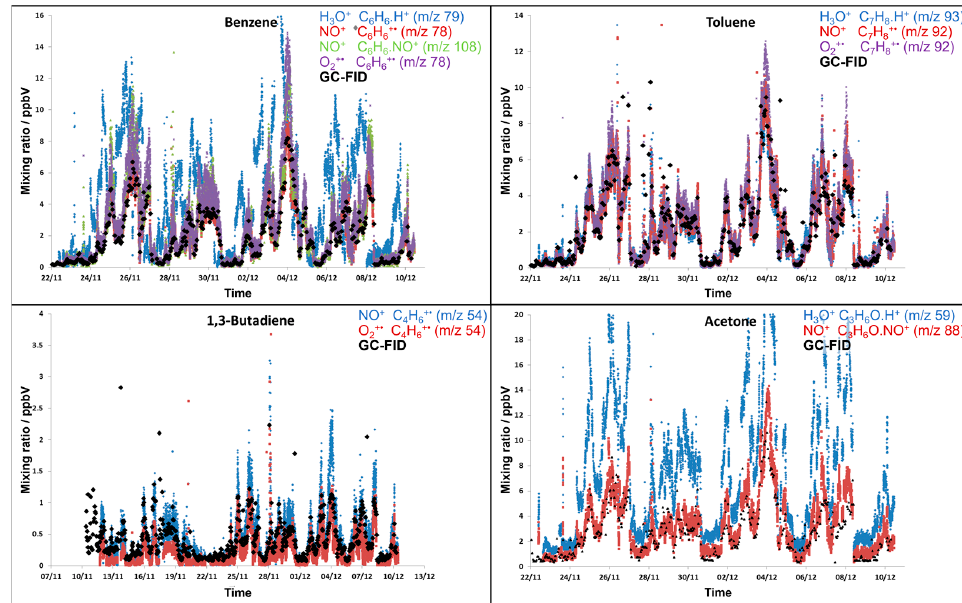
Figure 5. Mixing ratios (concentrations) for ambient air in Beijing during winter 2016, as measured using DC-GC-FID and SIFT-MS [123]. Legend text color matches relevant data series. Unpublished conference poster illustration reproduced with permission of the authors.